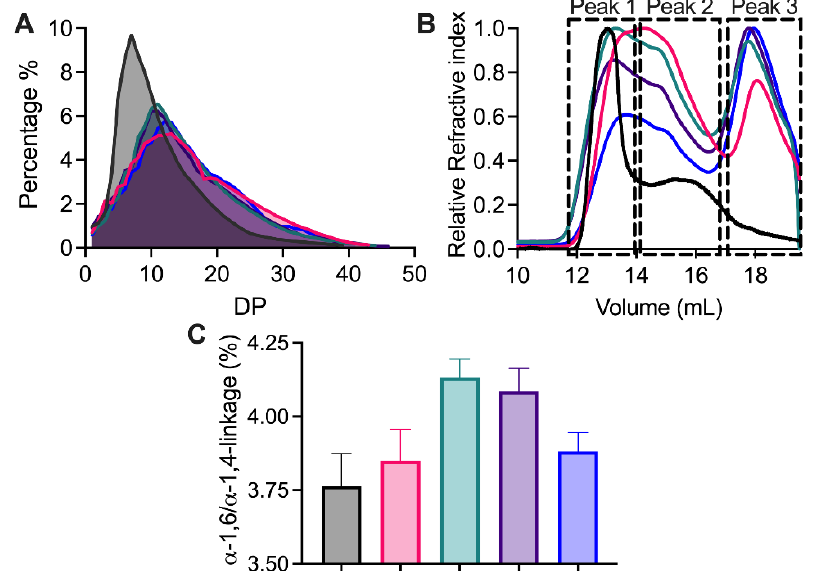
Figure 5. Structural analysis of NMS modified by Tu α GT and SBD-Tu α GT fusions. ( A ) Chain length distribution; ( B ) Molecular weight distribution; ( C ) 1 H-NMR analysis of α -1,6/ α -1,4 linkage ratio. Before (black), after modification by Tu α GT (red), SBD St1 -Tu α GT (green), SBD St2 -Tu α GT (purple), and SBD GA -Tu α GT (blue).